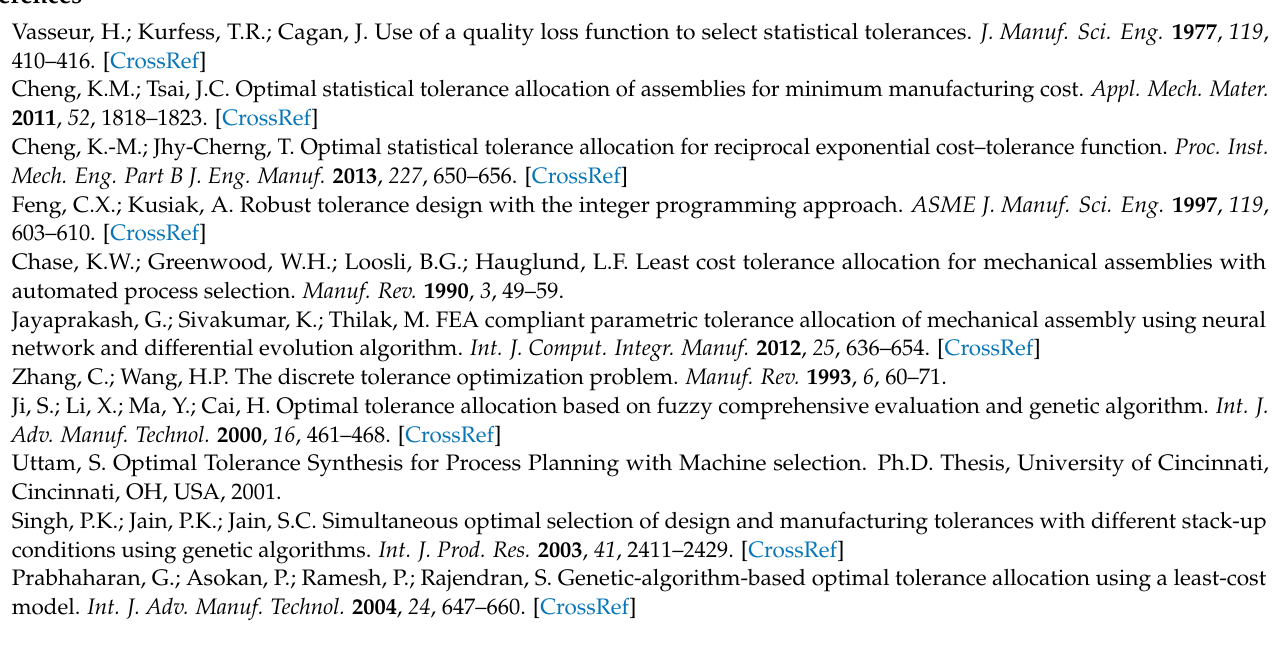
Figure S3: Selection of best machine for process number 1 to 9 to manufacture KJA, Table S1: Summary of literature survey, Table S2: Feasibility Matrix for WMA [Geetha et al. (2013)], Table